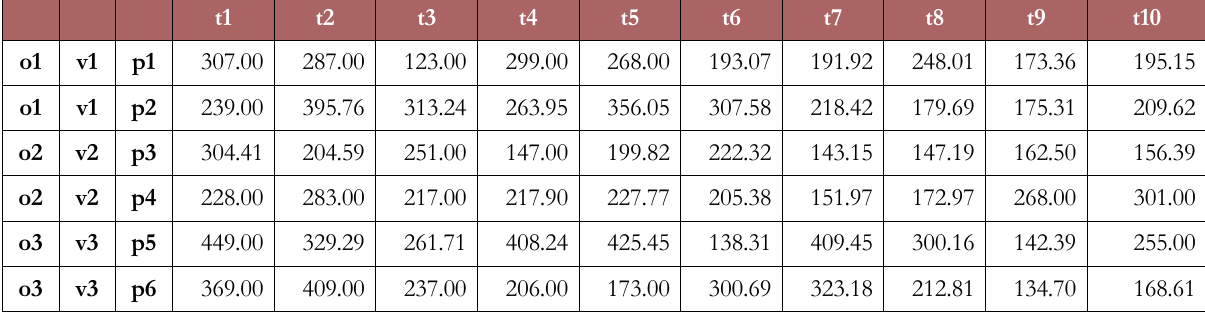
Table 6. Shipping quantity from the manufacturer to the advanced warehouse QV